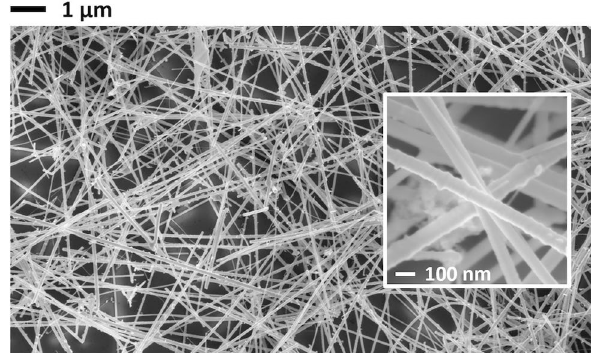
Fig. 2 SEM image (scale bar = 1 µm) of an annealed Ge NW network; the inset shows a large-scale magnification (scale bar = 100 nm)